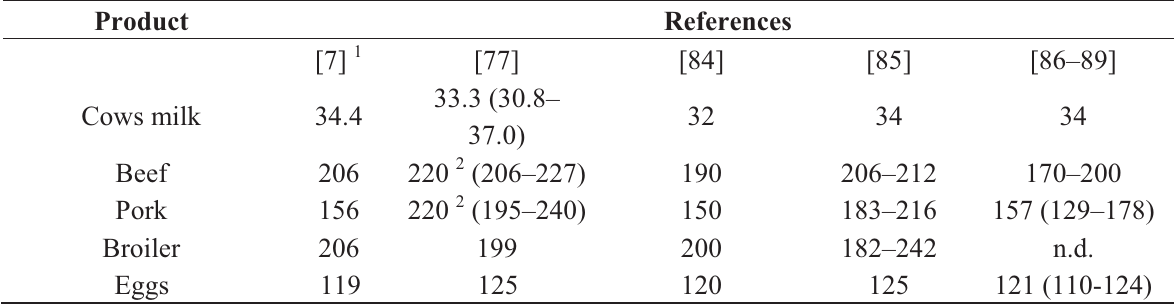
Table 6. Published data regarding the protein content of some edible animal products (in g per kg edible product).